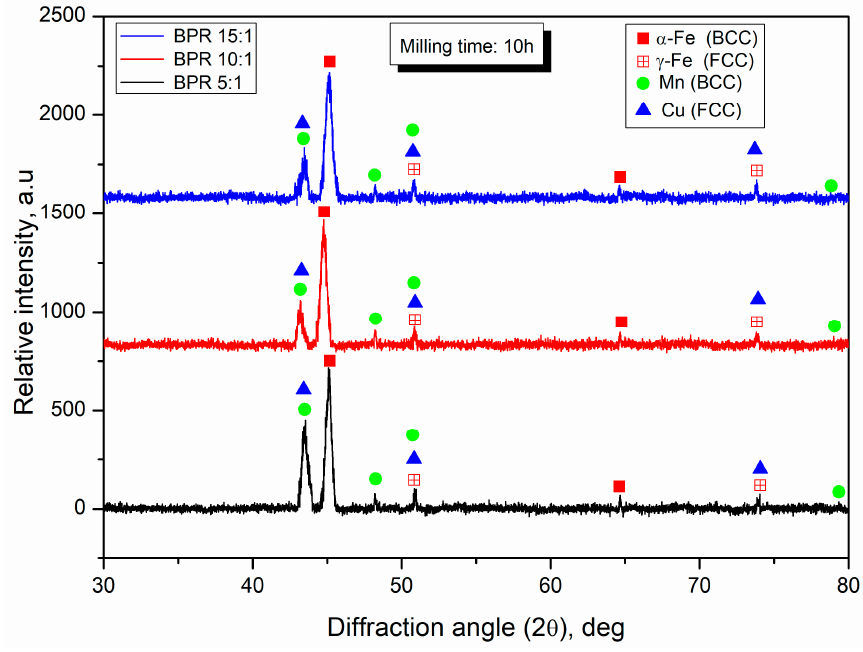
Figure 3. X-ray diffraction peak profiles of FeMn30Cu5 biodegradables hot-forged alloys milled at different BPRs (black color: BPR 5:1; red color: BPR 10:1; blue color: BPR 15:1). Table 2. Influence of BPR on full width half maximum, peak intensity, center of peak, and area of peak after 10 h MA with different BPRs of FeMn 30 Cu 5 biodegradables hot-forged alloys .